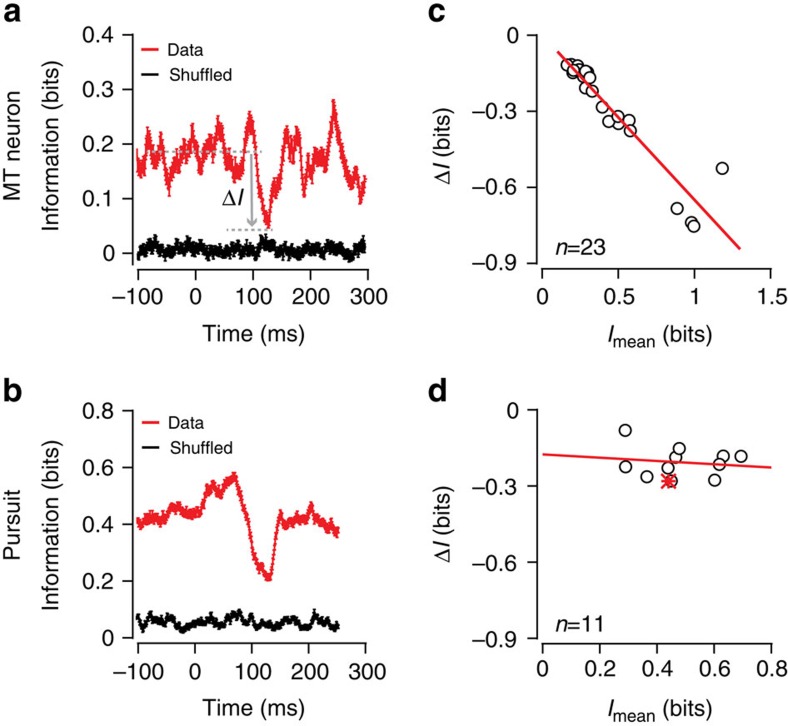
Rapid recovery of mutual information after variance step.(a) Red trace: mutual information between stimulus direction and spike count (firing rate) for a single MT neuron computed in a sliding 60 ms time window across a HTL variance step (s.d.=35° to 12°); (black trace) shuffled data. (b) Mutual information between eye and target direction from a single data set across an HTL variance shift (s.d.=15 to 5°). We plotted ΔI, the difference between the minimum information value at the dip and the time-averaged information level before the dip, that is, <I>, against <I> for the (c) MT data (n=23) and (d) pursuit data (n=11, 3 monkeys). Red lines represent linear regressions. For MT, the information dip was a constant fraction of the average information value (slope=−0.65, R2=0.88, n=23). For pursuit, the dip was less dependent on the information level, 0.21±0.06 bits (slope=−0.06, R2=0.02, n=11). The red star in d indicates the simulated neural population prediction for pursuit, which is quite close to the observed data (see text).